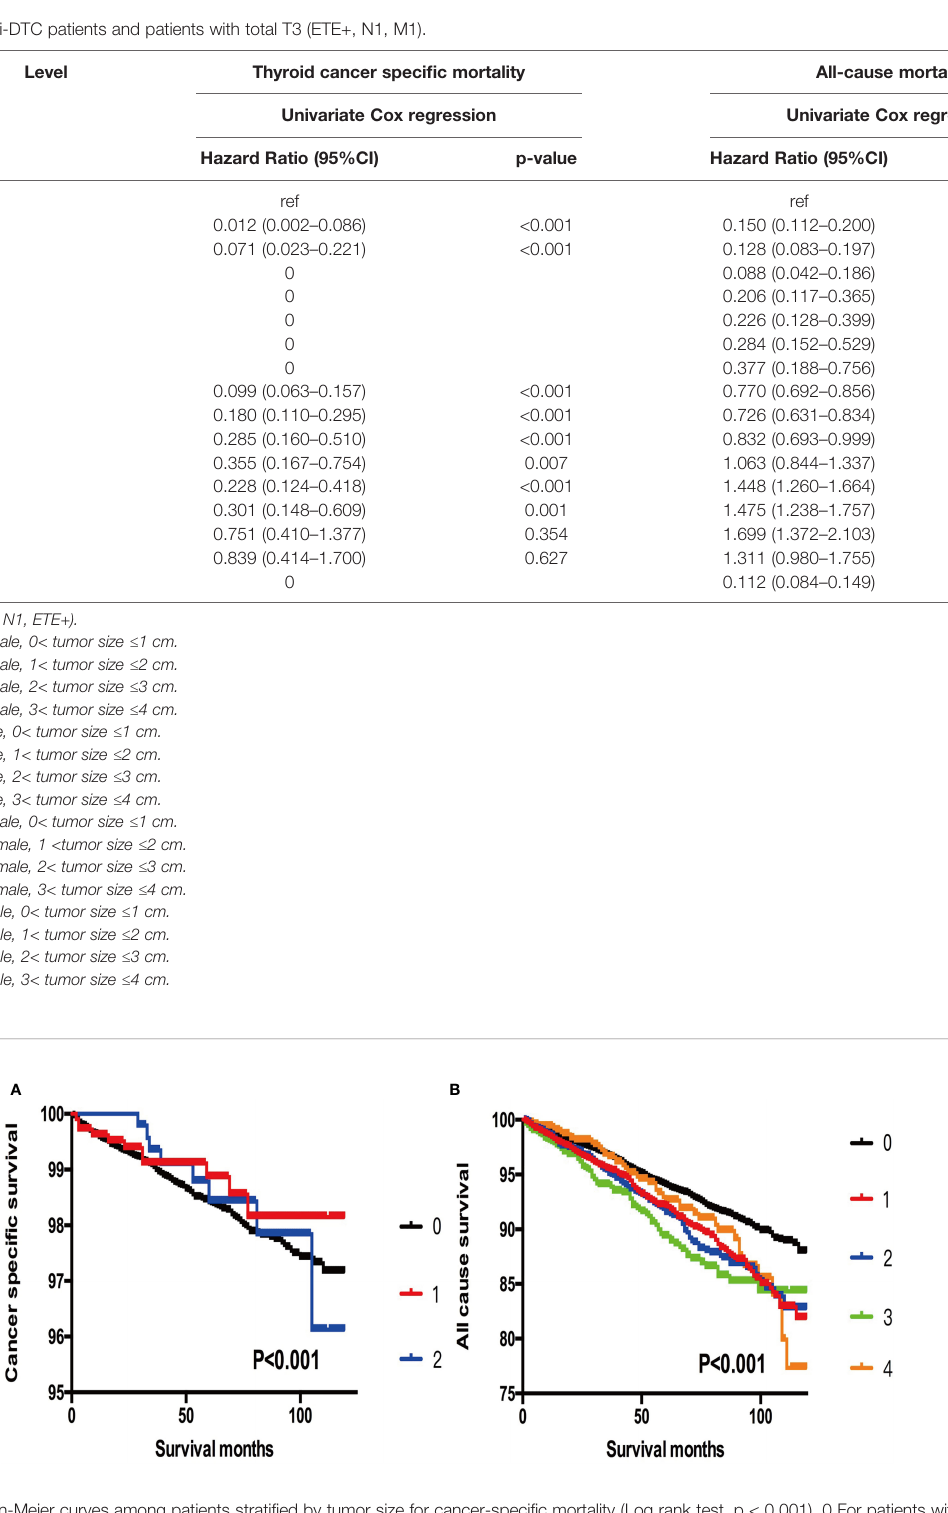
FIGURE 1 | (A) Kaplan-Meier curves among patients strati fi ed by tumor size for cancer-speci fi c mortality (Log rank test, p < 0.001). 0 For patients with thyroid cancer > 4 cm in size, gross extrathyroidal extension (clinical T3), or clinically apparent metastatic disease to nodes (clinical N1) or distant sites (clinical M1). 1 Male, > 45 years old, tumor size 2-3 cm. 2 Male, > 45 years old, tumor size 3-4 cm. (B) Kaplan-Meier curves among patients strati fi ed by tumor size for all-cause mortality (Log rank test, p < 0.001). 0 For patients with thyroid cancer> 4 cm, gross extrathyroidal extension (clinical T3), or clinically apparent metastatic disease to nodes (clinical N1) or distant sites (clinical M1). 1 Male, > 45 years old, tumor size 0-1 cm. 2 Male, > 45 years old, tumor size 1-2 cm. 3 Male, > 45 years old, tumor size 2- 3 cm. 4 Male, > 45 years old, tumor size 3-4